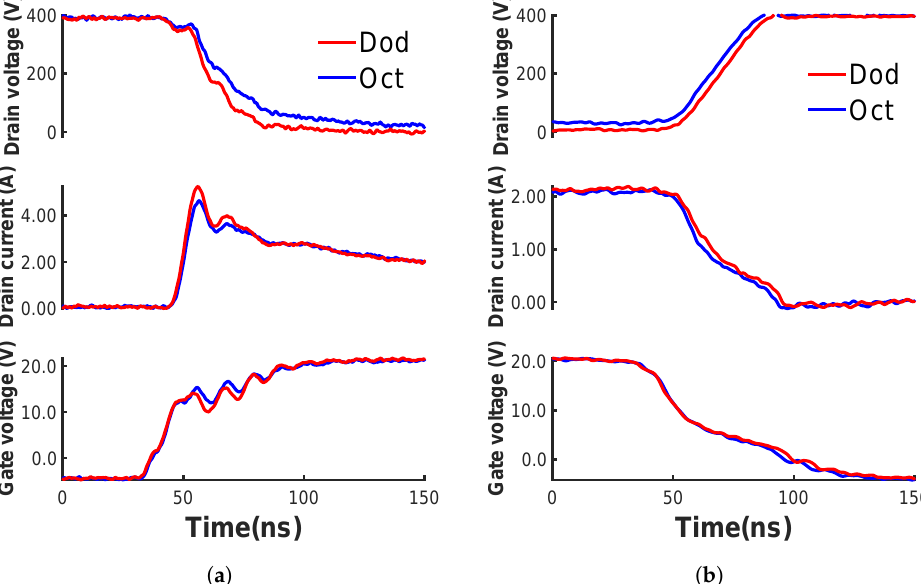
Figure 4. ( a ) Turn-on and ( b ) turn-off waveforms of the fabricated 650V SiC power MOSFETs with the Dod and the Oct